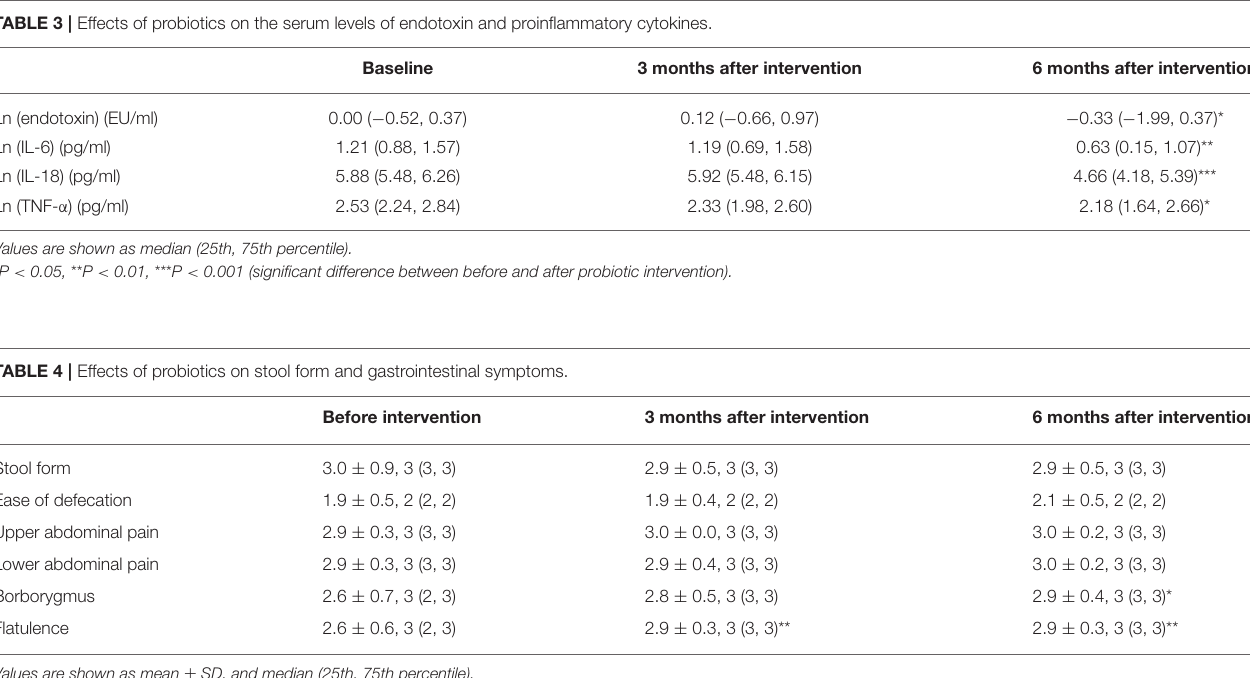
eGFR, estimated glomerular filtration rate.